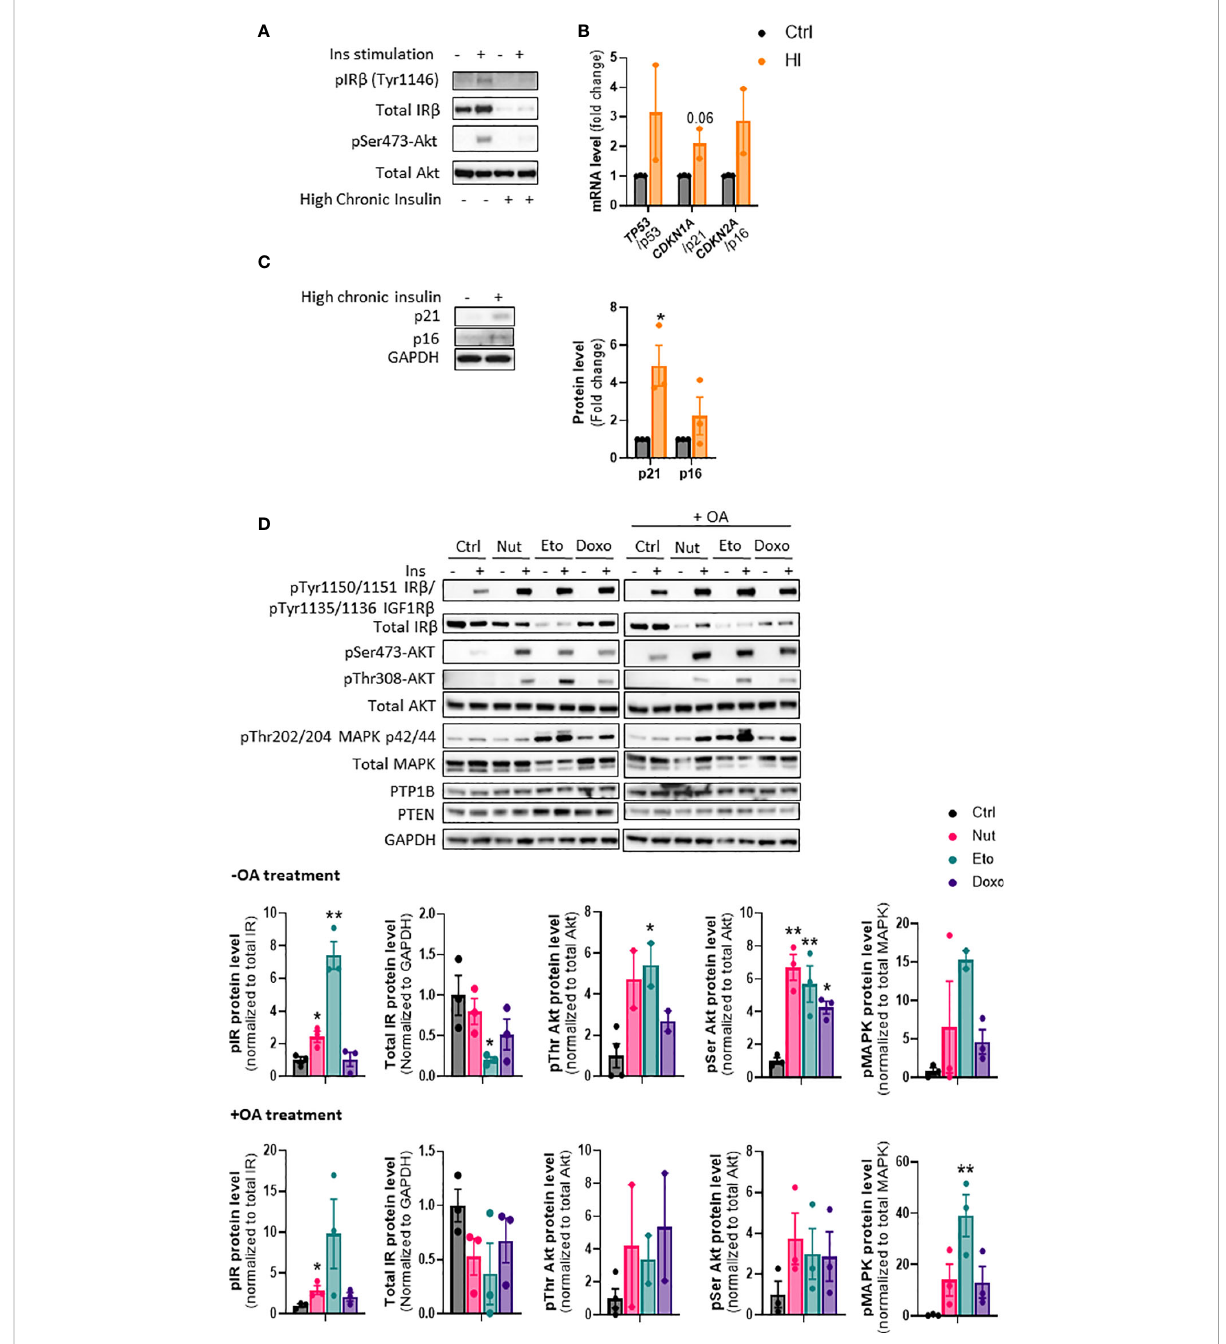
FIGURE 6 Cellular senescence increases insulin sensitivity in human hepatocytes. (A) IHH cells were chronically treated with high insulin levels (100 nM) for 5 days to induce insulin resistance. Western blot analysis of insulin receptor (IR) Tyr1146 and Akt Ser473 phosphorylation following acute 10 min insulin (10 nM) stimulation. (B) mRNA expression of senescence markers normalized to GAPDH after 5 days of culture with high insulin levels. (C) Western blot analysis and quanti fi cation of senescence markers p21 and p16 normalized to GAPDH, in IHH cells after 5 days of culture with high insulin levels. (D) IHH cells were treated with senescence-inducing drugs for 5 days, with or without the addition of oleic acid for another 24h, and acutely stimulated with insulin (10 nM) for 10 min. Western blot analysis and quanti fi cation of proteins involved in the insulin signaling pathway, in the insulin-stimulated conditions. GAPDH image is similar to that of Figure 5B as levels of different proteins were measured using the same membranes. Results are expressed as Mean ± SEM. *P < 0.05, **P < 0.01 indicates a signi fi cant difference compared to control